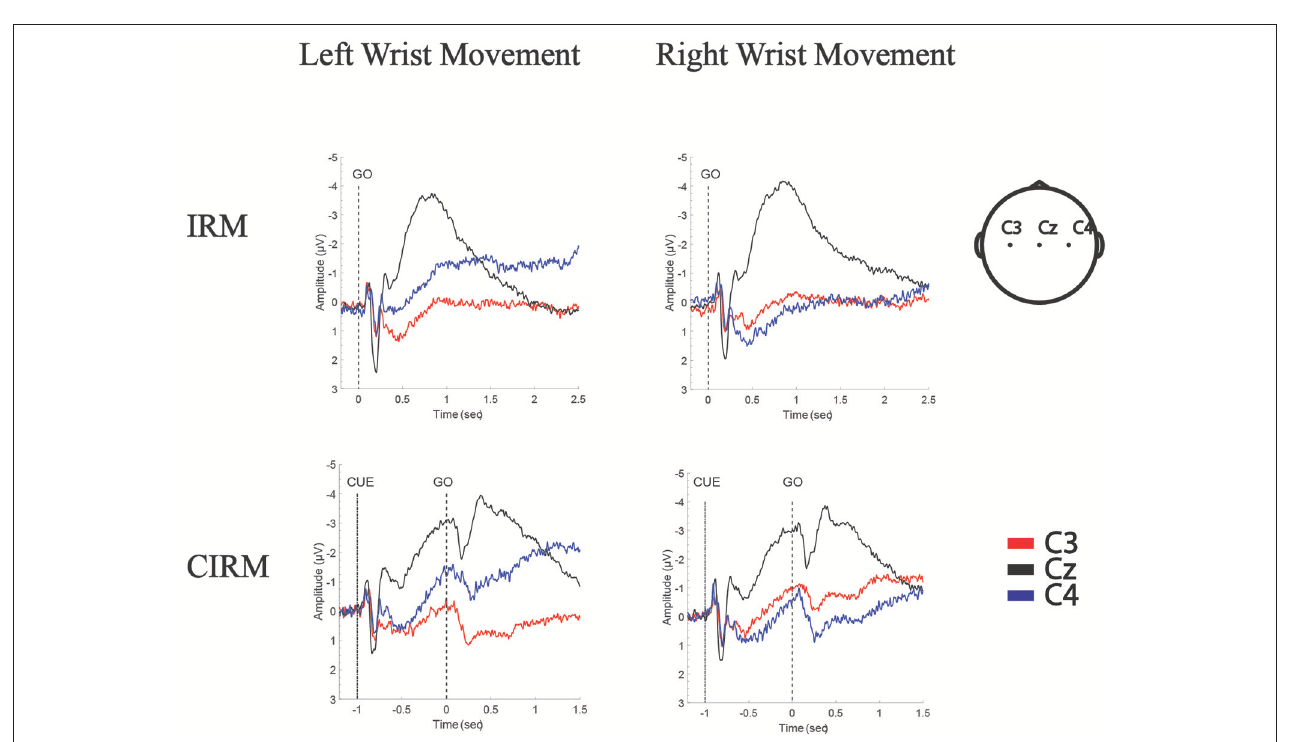
FIGURE 3 | Grand Average of MRCPs of all subjects in IRM and CIRM. MP is presented in movement execution stage of both tests, and CNV is presented in movement preparation stage of CIRM. Negative Upwards.